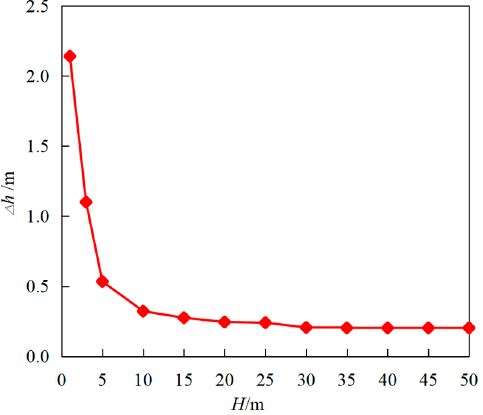
Figure 14. The relationship between step sinking and immediate roof thickness.